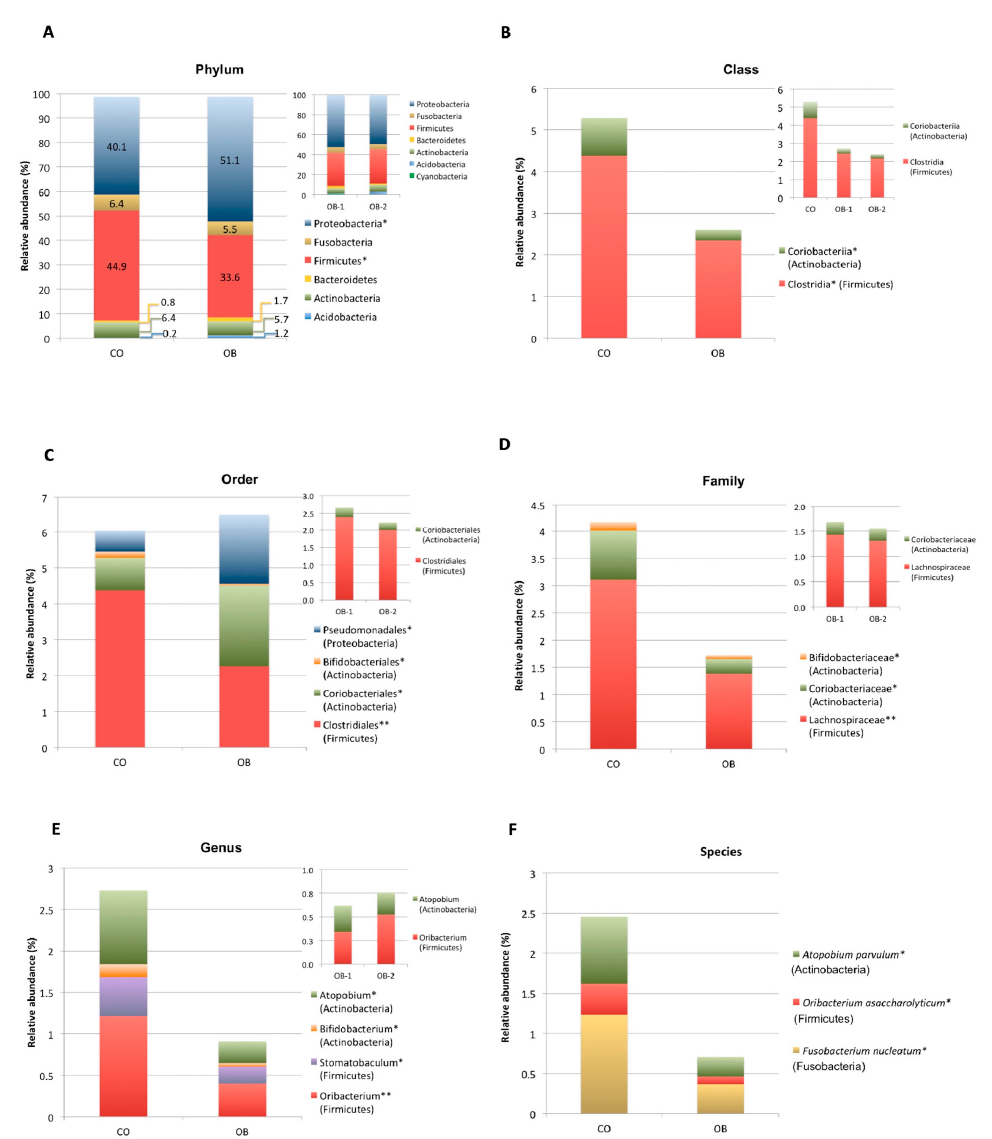
Figure 3. Composition analysis of gut microbiomes in the Control (CO) and Obese (OB) groups. The barplots show the relative abundance (%) of the 6 taxonomic levels from Phylum to Species, according to the SILVA database v.128. Each column in the plot represents a group, and each colour in the column represents the relative abundance (%) for each taxon. ( A ) Phyla having average abundance greater than 1% in at least one group of study were reported. Proteobacteria and Firmicutes were significant most and less abundant phyla, in obese respect to normal weight control group, respectively. ( B–F ): The barplots show the relative abundance (%) of taxonomic groups at class ( B ), order ( C ), family ( D ), genus ( E ) and species ( F ) levels which resulted significantly di ff erent among the two groups by Kruskal Wallis test. Not statistically significant di ff erence in taxa abundance was observed when obese groups (see upper right corner of panels A-E). * p < 0.05, ** p <